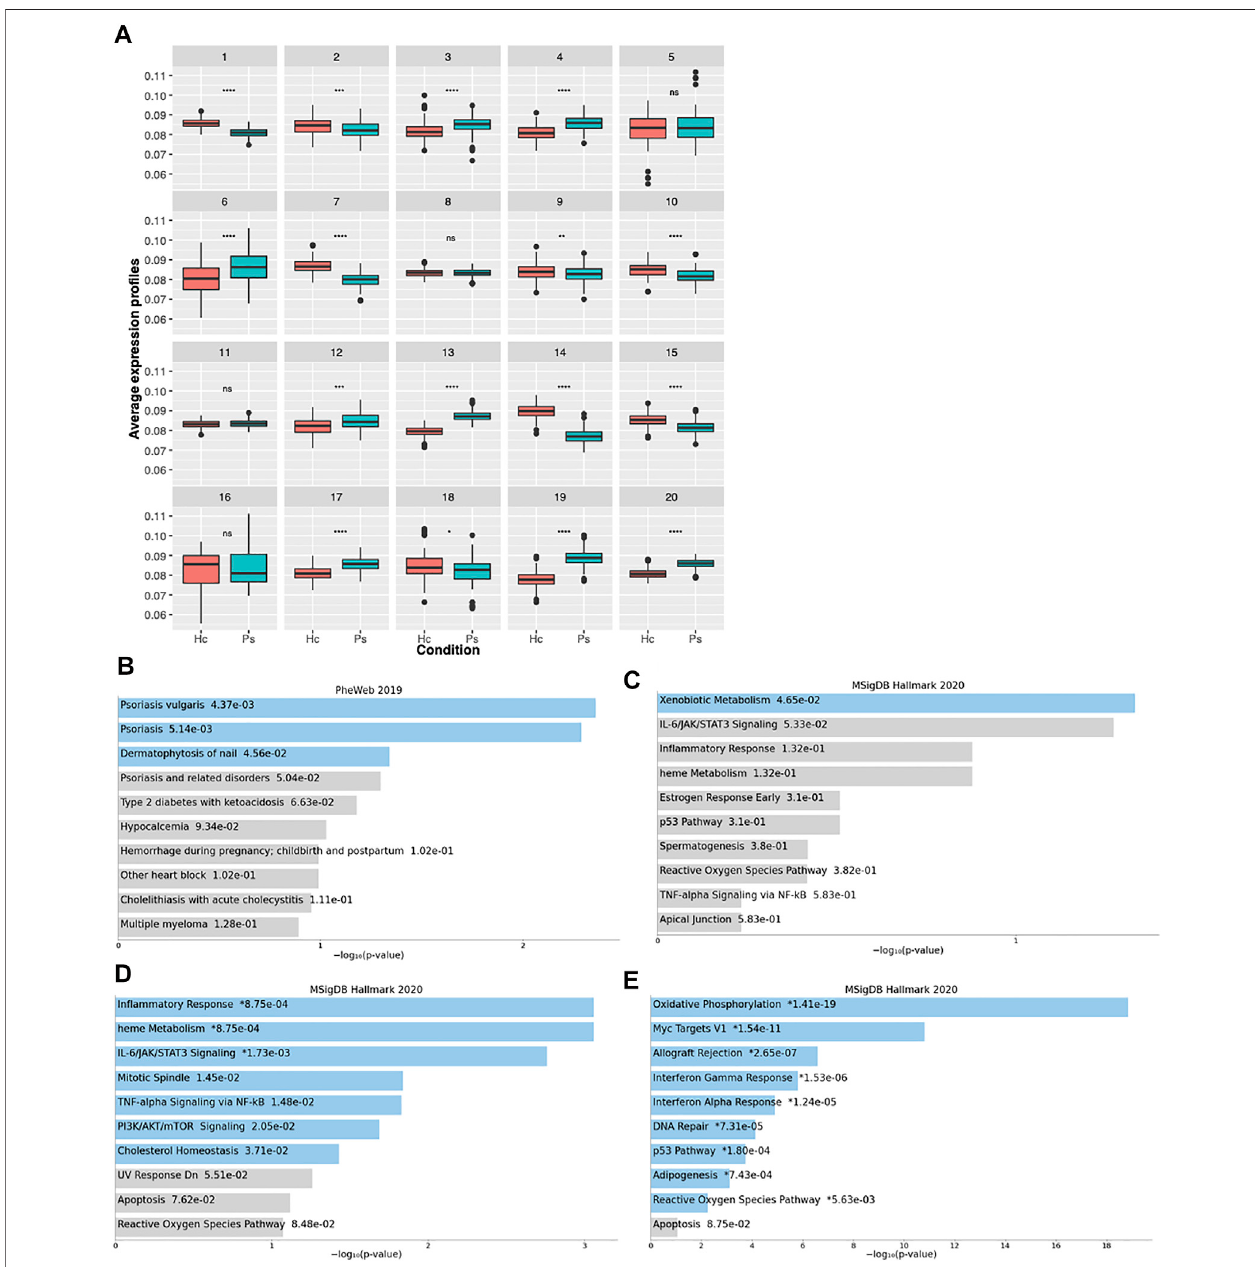
FIGURE 5 | Transcriptional landscape of psoriatic disease-affected MZ twins. (A) Boxplots indicating the clusters identi fi ed by Coseq2 software, characterized by co-expressed genes. For each cluster, the average expression pro fi le of all the genes belonging to the cluster is shown in affected and non-affected MZ twins. The p -values, as calculated by the Wilcoxon rank sum test are displayed at the top of each boxplot. * p < 0.05, ** p < 0.01, *** p < 0.001, **** p < 0.0001, ns not signi fi cant. Ps: Pso/PsA MZ twin, Hc: unaffected twin. (B – E) The bar charts show the top 10 enriched terms in the chosen library (MSig DB Hallmark or PheWas), along with their corresponding p -values, for clusters 19 (B,C) , 13 (D) , 14 (E) . Colored bars correspond to terms with signi fi cant p -values ( < 0.05). An asterisk (*) next to a p -value indicates the term also has a signi fi cant adjusted p -value ( < 0.05).